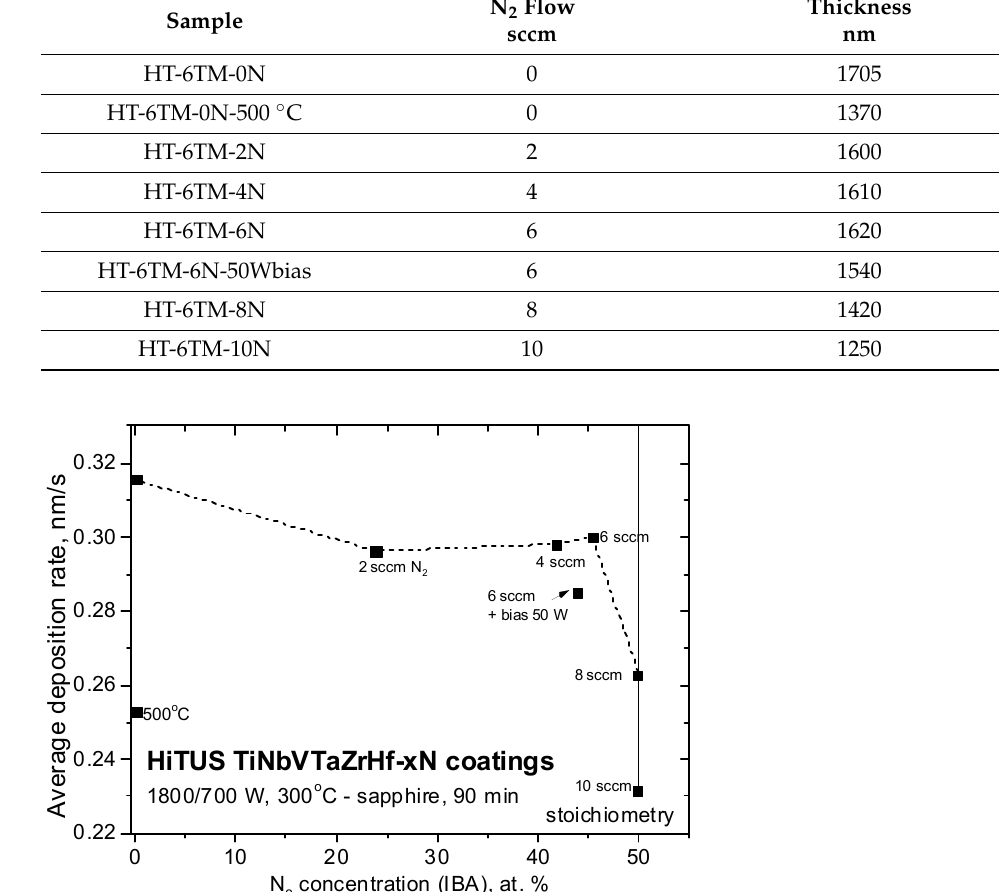
Table 2. The list of the studied TiNbVTaZrHf–N coatings prepared by reactive HiTUS and their thicknesses measured on fracture cross-sections (see Figure 3).